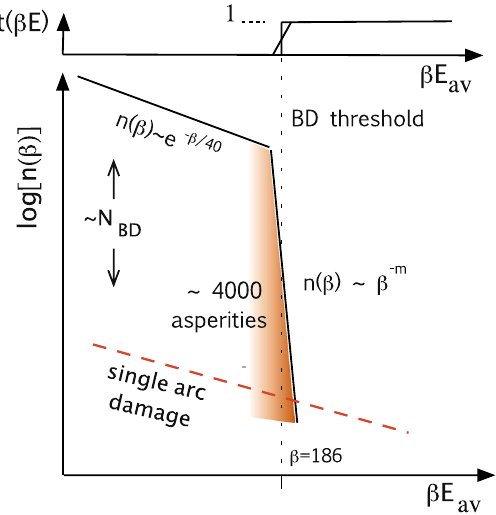
Figure 7. The spectrum, of asperities, n (β) , with the threshold for breakdown t (β E ) for a conditioned system 9 . The spectrum of asperities on the arcing surface evolves during conditioning due to creation of asperities with higher β s, due to single arcs. These must eventually be burned off by arcing. This is done at lower voltages to minimize generation of high β asperities. Not to scale.